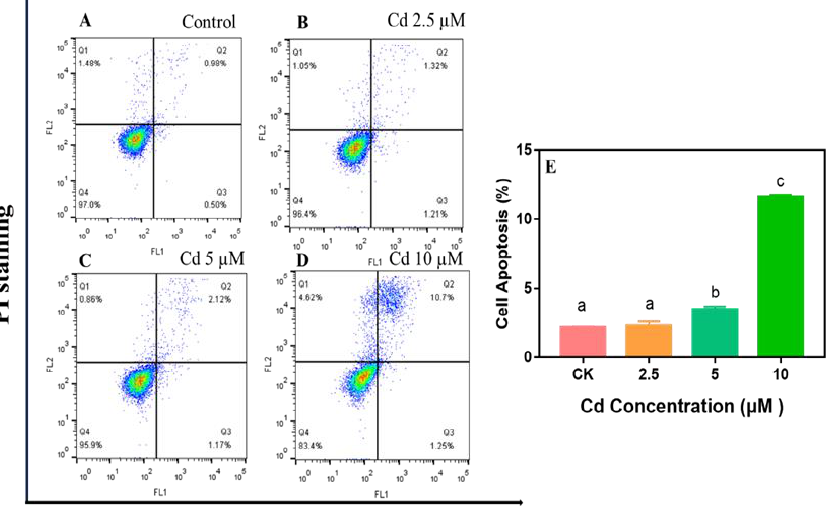
Figure 5. Apoptosis of HaCaT cells was measured using Annexin V-FITC/PI staining by flow cytometry after exposure to 2.5–10 µ M Cd for 24 h ( A – D ). The statistical analysis graph presents cell apoptosis rate (Q2 + Q3 quadrant) ( E ). Different letters above the columns indicate a significant difference ( p < 0.05).